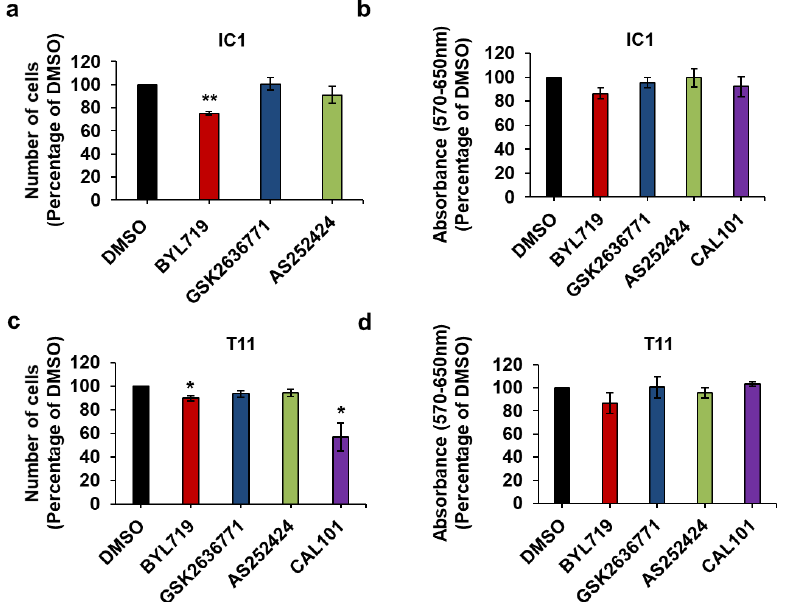
Figure 8. IC1 and T11 cells are more resistant to treatment with isoform-specific PI3K inhibitors than IC8 and Met1 cells. IC1 ( a , b ) and T11 ( c , d ) cells were treated with 1 µM of the indicated inhibitors or vehicle (DMSO) in complete medium supplemented with 10% FBS. After 72 h, number of cells was assessed by cell counting ( a , c ) and cell viability was assessed by MTT assays ( b , d ). Data are expressed as percentage of results from cells treated with DMSO and are means ± SEM from n = 3 (( a ), apart from AS252424, n = 4), n = 4 (( b ), apart from CAL101 n = 3), n = 4 (( c ), apart from CAL101 n = 5) and n = 4 (( d ) , apart from AS252424 and CAL101 n = 3) independent experiments performed in duplicate ( a , c ) or triplicate ( b , d ). * p < 0.05, ** p < 0.01 vs. DMSO. Combined results from cell counting and MTT assays indicate that IC1 and T11 cells are more resistant to PI3K inhibition, in particular to p110 α inhibition, compared to IC8 and Met1 cells.